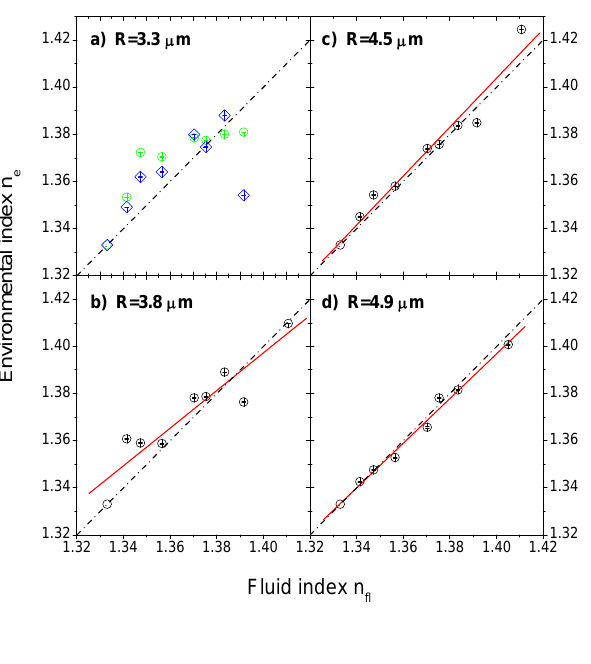
Figure 5. Environmental refractive index, n , experienced by the different beads as e , of the DI determined by the fitting procedure in dependence of the fluid index, n fl water/glycerol mixture injected into the microfluidic flow cell. The dash-dotted lines indicate the expected 1:1 behavior; the red solid lines are linear fits to the data. The errors shown are the  errors calculated from a variation of Equation 2. For details, see  10% main